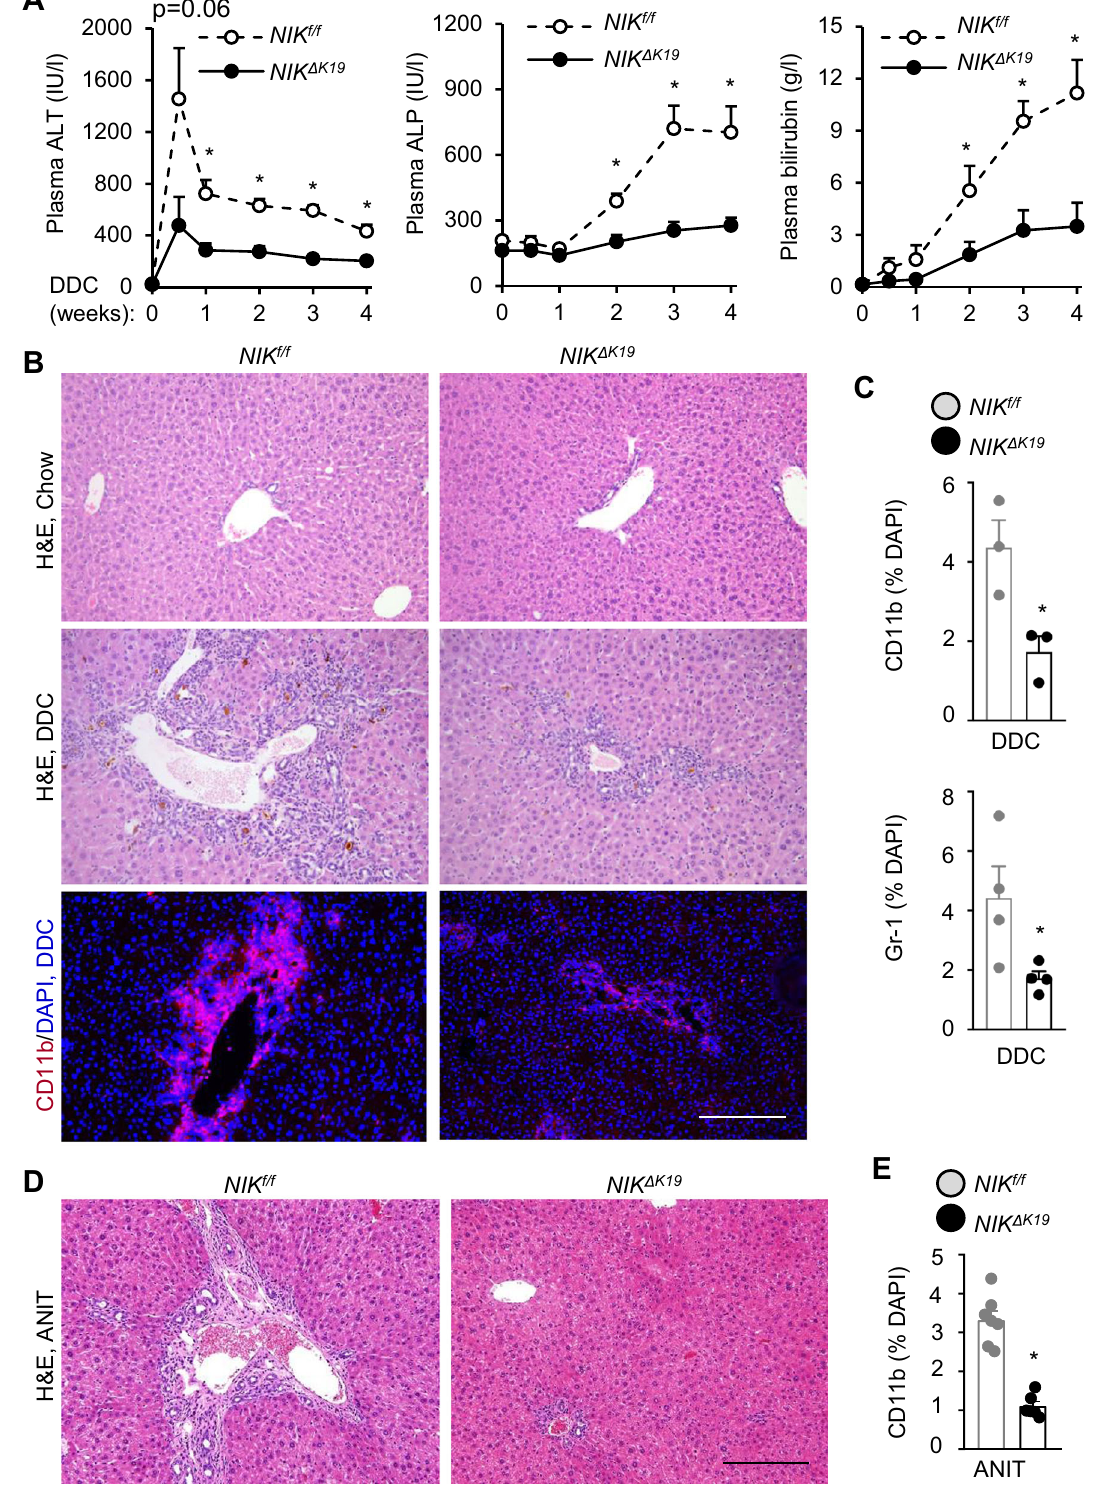
Fig. 4 | Ablation of biliary NIK ameliorates DDC-induced liver injury and in fl ammation. A – C NIK Δ K19 and NIK f/f male mice were fed a DDC diet for 4weeks. A Plasma ALT, ALP and total bilirubin levels. NIK f/f : n =8 mice, NIK Δ K19 : n =9 mice. B , C Liver sections were stained with H&E or antibodies to CD11b, and Gr-1. B Representativeimages.Scalebar:200 μ m. C CD11b( n =3micepergroup)andGr- 1 cells ( n =3 mice per group) were counted and normalized to total liver cell